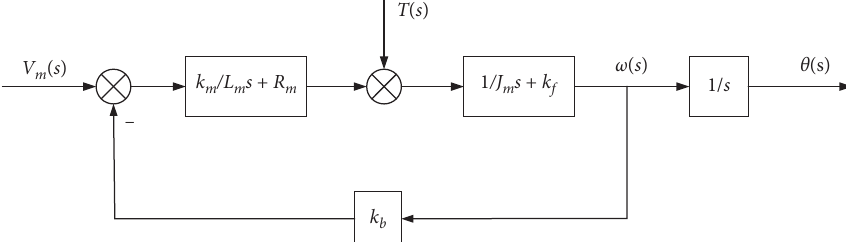
Figure 4: XQ WMR DC motor control structure diagram.